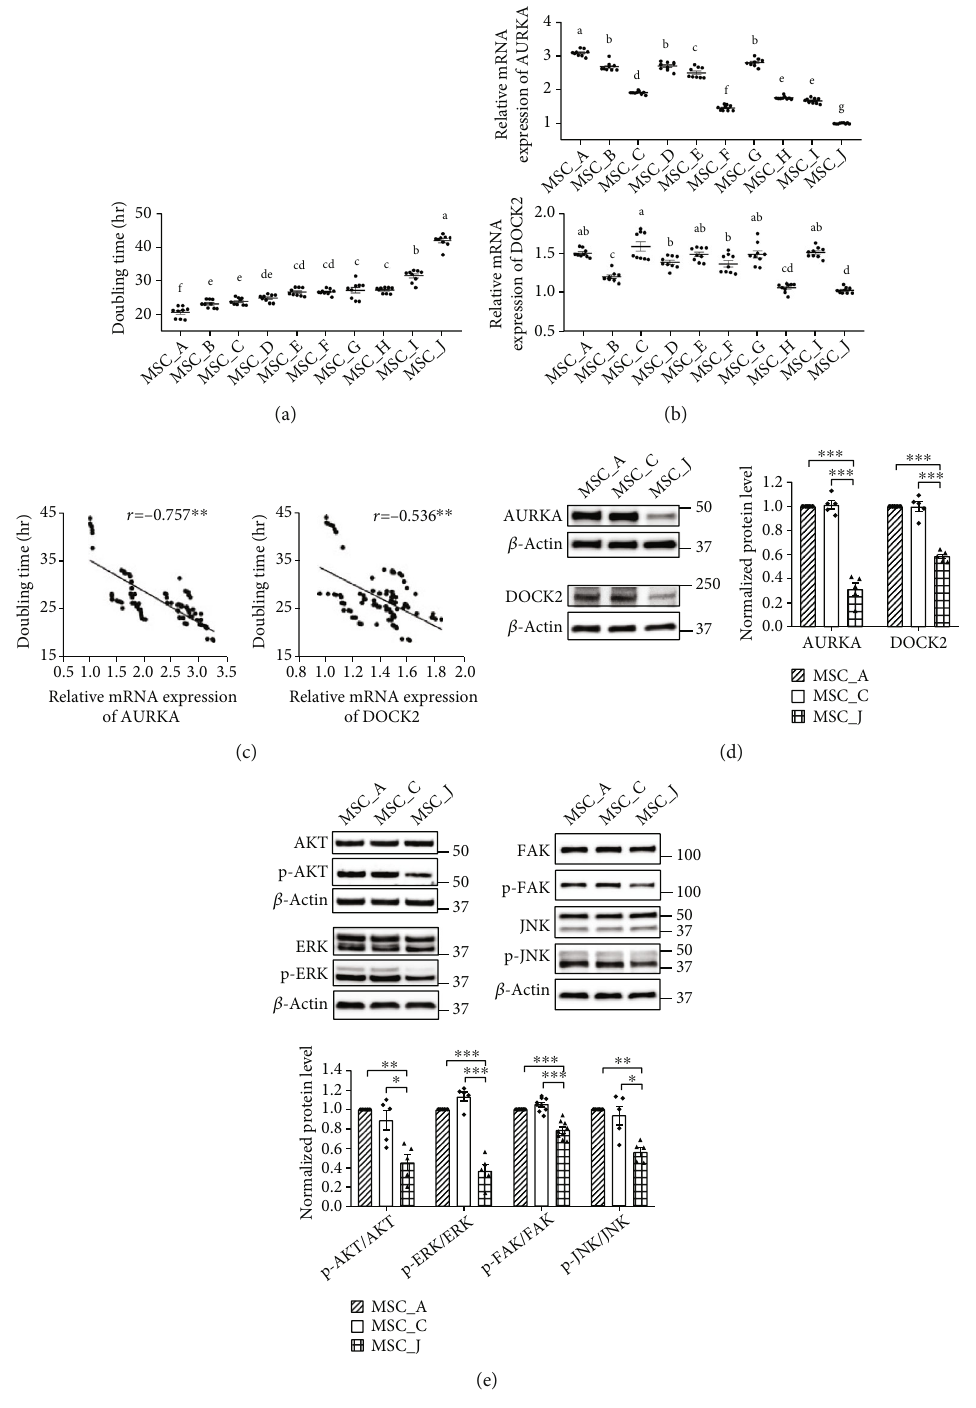
Figure 3: Correlation between doubling time and mRNA expression of AURKA and DOCK2 in WJ-MSCs. (a) The graph shows doubling time in ten lots of WJ-MSCs. (b) Real-time qRT-PCR analysis showed mRNA expression levels of AURKA and DOCK2 in WJ-MSCs. Relative mRNA expression indicates the value converted based on that of MSC_J. Di ff erent letters above bars mean signi fi cant di ff erence from others (one-way ANOVA followed by Tukey ’ s multiple range test, p < 0 : 05 ). (c) Pearson ’ s correlation analysis con fi rmed a strong negative relationship between mRNA expression levels of AURKA and doubling time across the lots of WJ-MSCs. mRNA expression levels of DOCK2 and doubling time of WJ-MSCs showed a moderate negative relationship. (d) Western blotting of the protein levels of AURKA and DOCK2 in three WJ-MSCs. (e) Western blotting of the phosphorylation level of AKT, ERK, FAK, and JNK in three WJ- MSCs. Normalized protein level indicates the value converted based on that of MSC_A. Data are shown as means ± SEM . One-way ANOVA with Tukey ’ s multiple comparisons test (a, b) and Dunnett ’ s multiple comparisons test (d, e). ∗∗∗ p < 0 : 001 , ∗∗ p < 0 : 01 , and ∗ p < 0 : 05